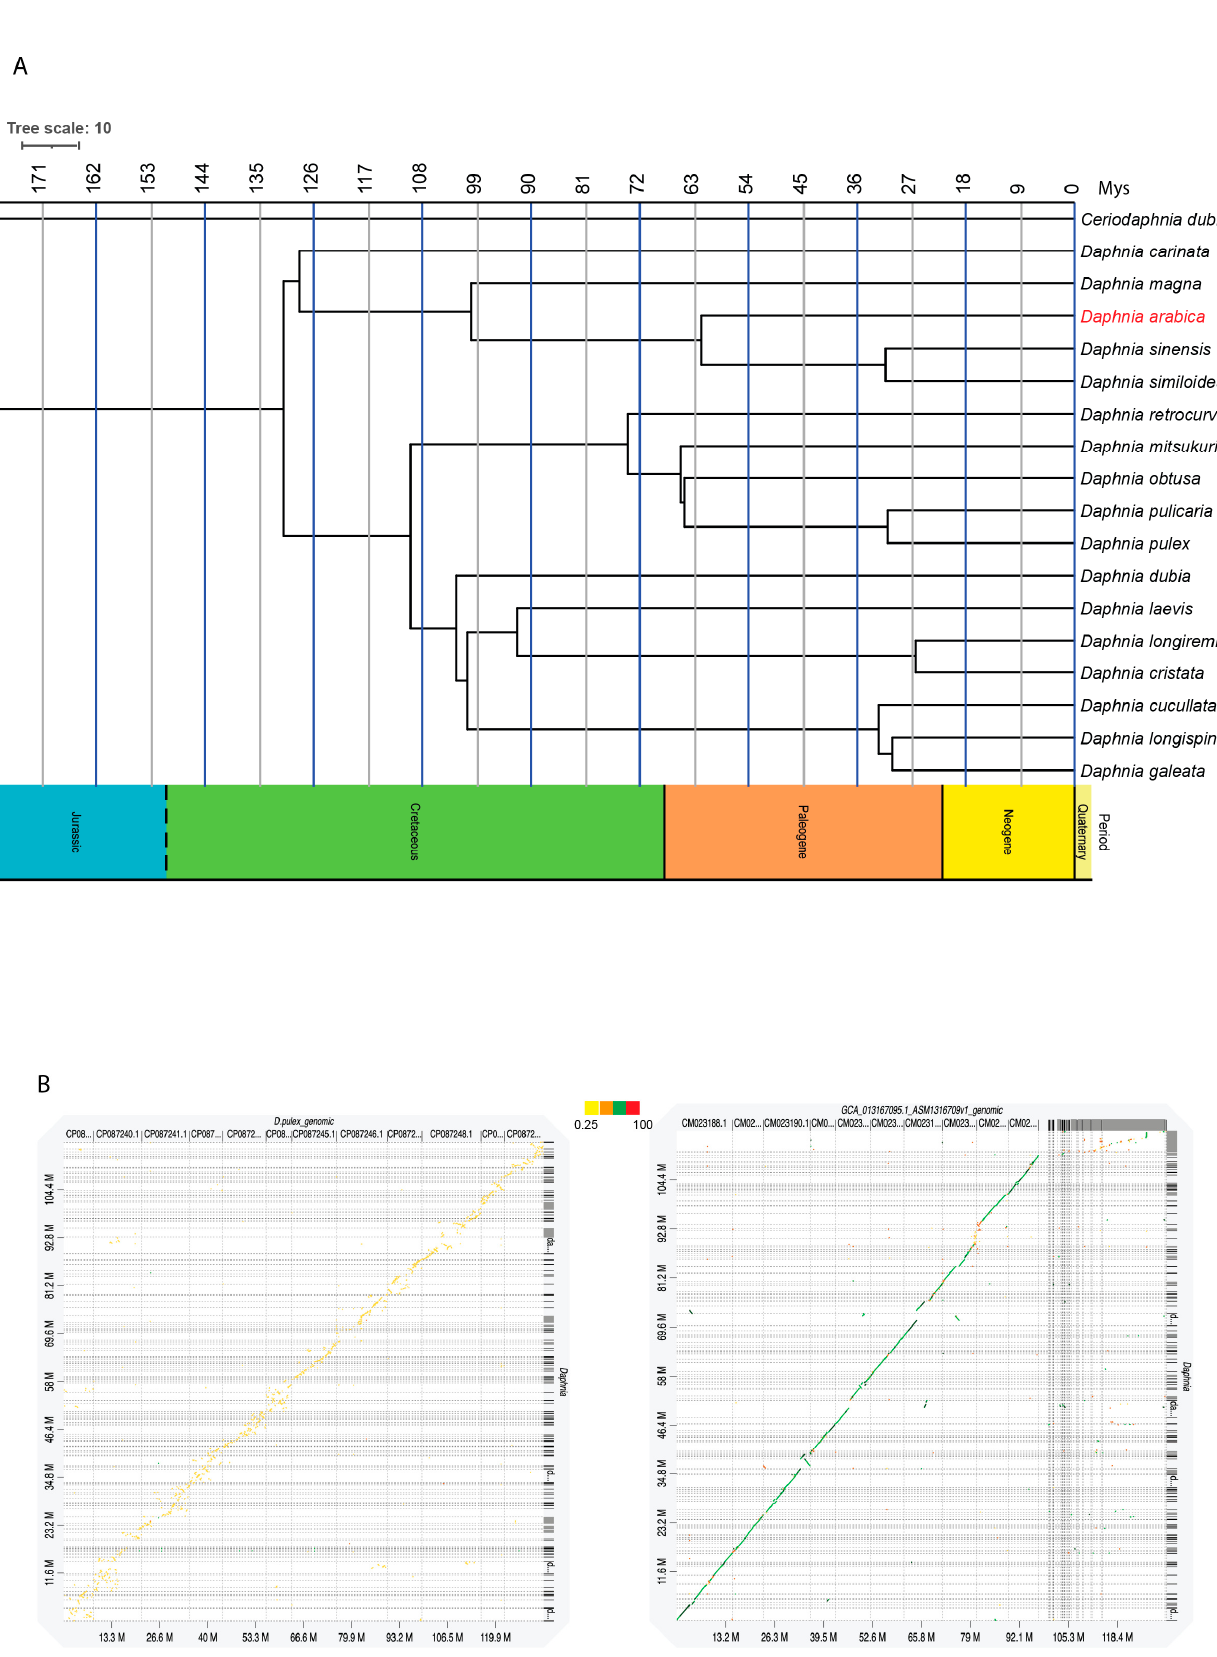
Figure 3. ( A ) Whole genome shot-gun sequence-based divergence time estimation of D. arabica. ( B ) Pairwise genome comparison D. arabica vs. D. pulex ( left ) and D. arabica vs. D. sinensis ( right